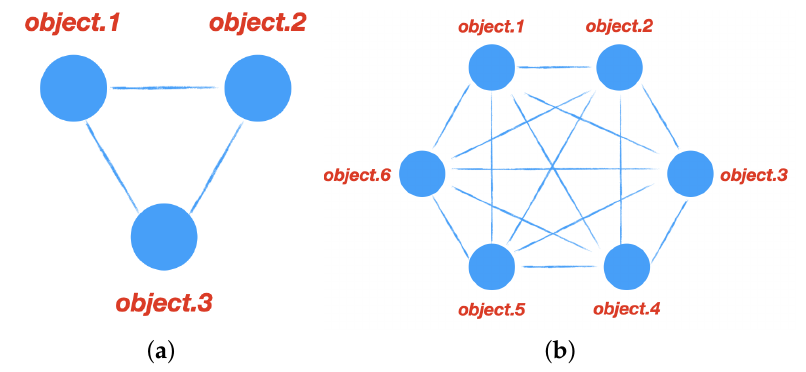
Figure 2. Schemes representing a combinatorial problem of a pairing, given N objects with N = 3 ( a ) and N = 6 ( b ).